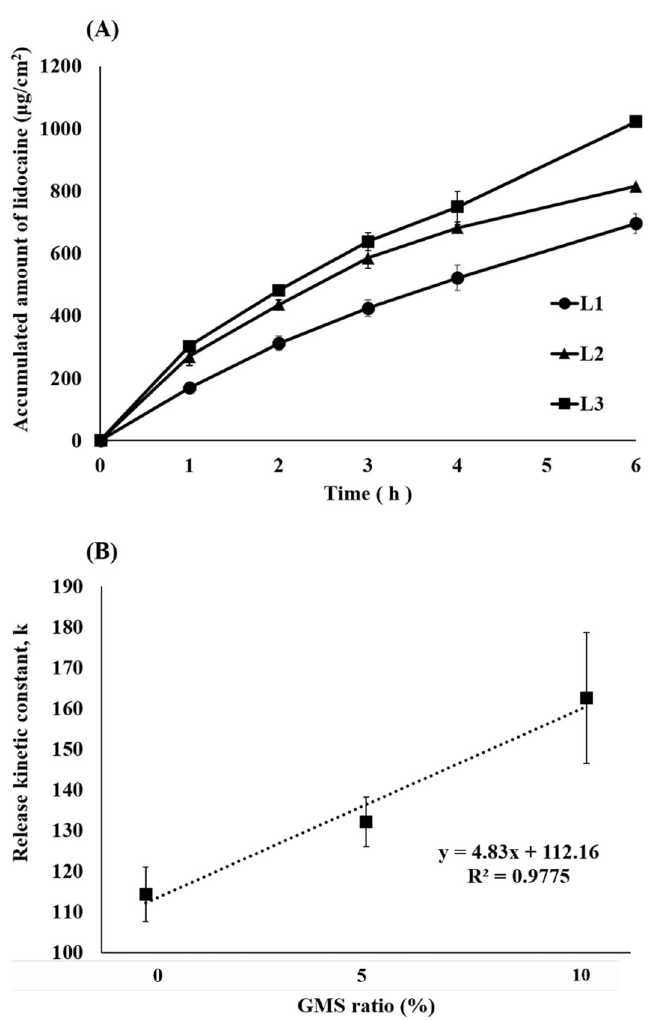
Figure 5. In vitro dissolution tests of lidocaine ointment. ( A ) Dissolution profile of prepared lidocaine ointments; ( B ) Correlation between kinetic constant (k) and GMS ratio (%) (mean ± standard deviation, n = 4). GMS: glycerol monostearate.